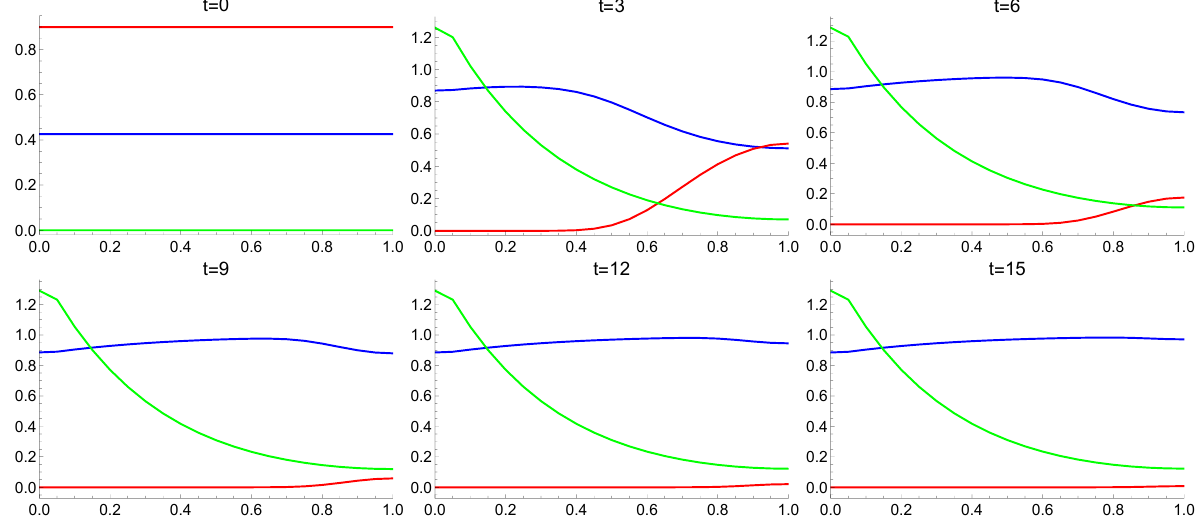
Fig. 3 Results of Simulation 3, with Ω = [ 0 , L ] = [ 0 , 1 ] . Plots of model solutions A ( x , t ) (cancer cells, red), N ( x , t ) (normal cells, blue) and D ( x , t ) (chemotherapeutic drug concentration, green) at time points t = 0 , 3 , 6 , 9 , 12 , 15. See Table 1 for parameter values used here. At time t = 0, the tumor is spread trough the tissue, and as chemotherapy is applied ( t > 0), the tumor cells are reduced and in the entire tissue. In comparison with Simulation 2, the tumor extinction is reached because the drug infusion rate µ is increased here. Within the entire tissue, the removal of tumor cells release the normal tissue to recover and